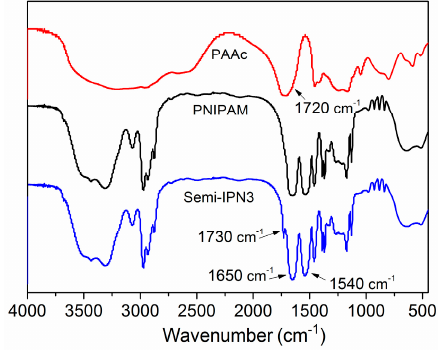
Figure 4. FT-IR spectra for the PAAc, PNIPAM, and semi-IPN3 microspheres.